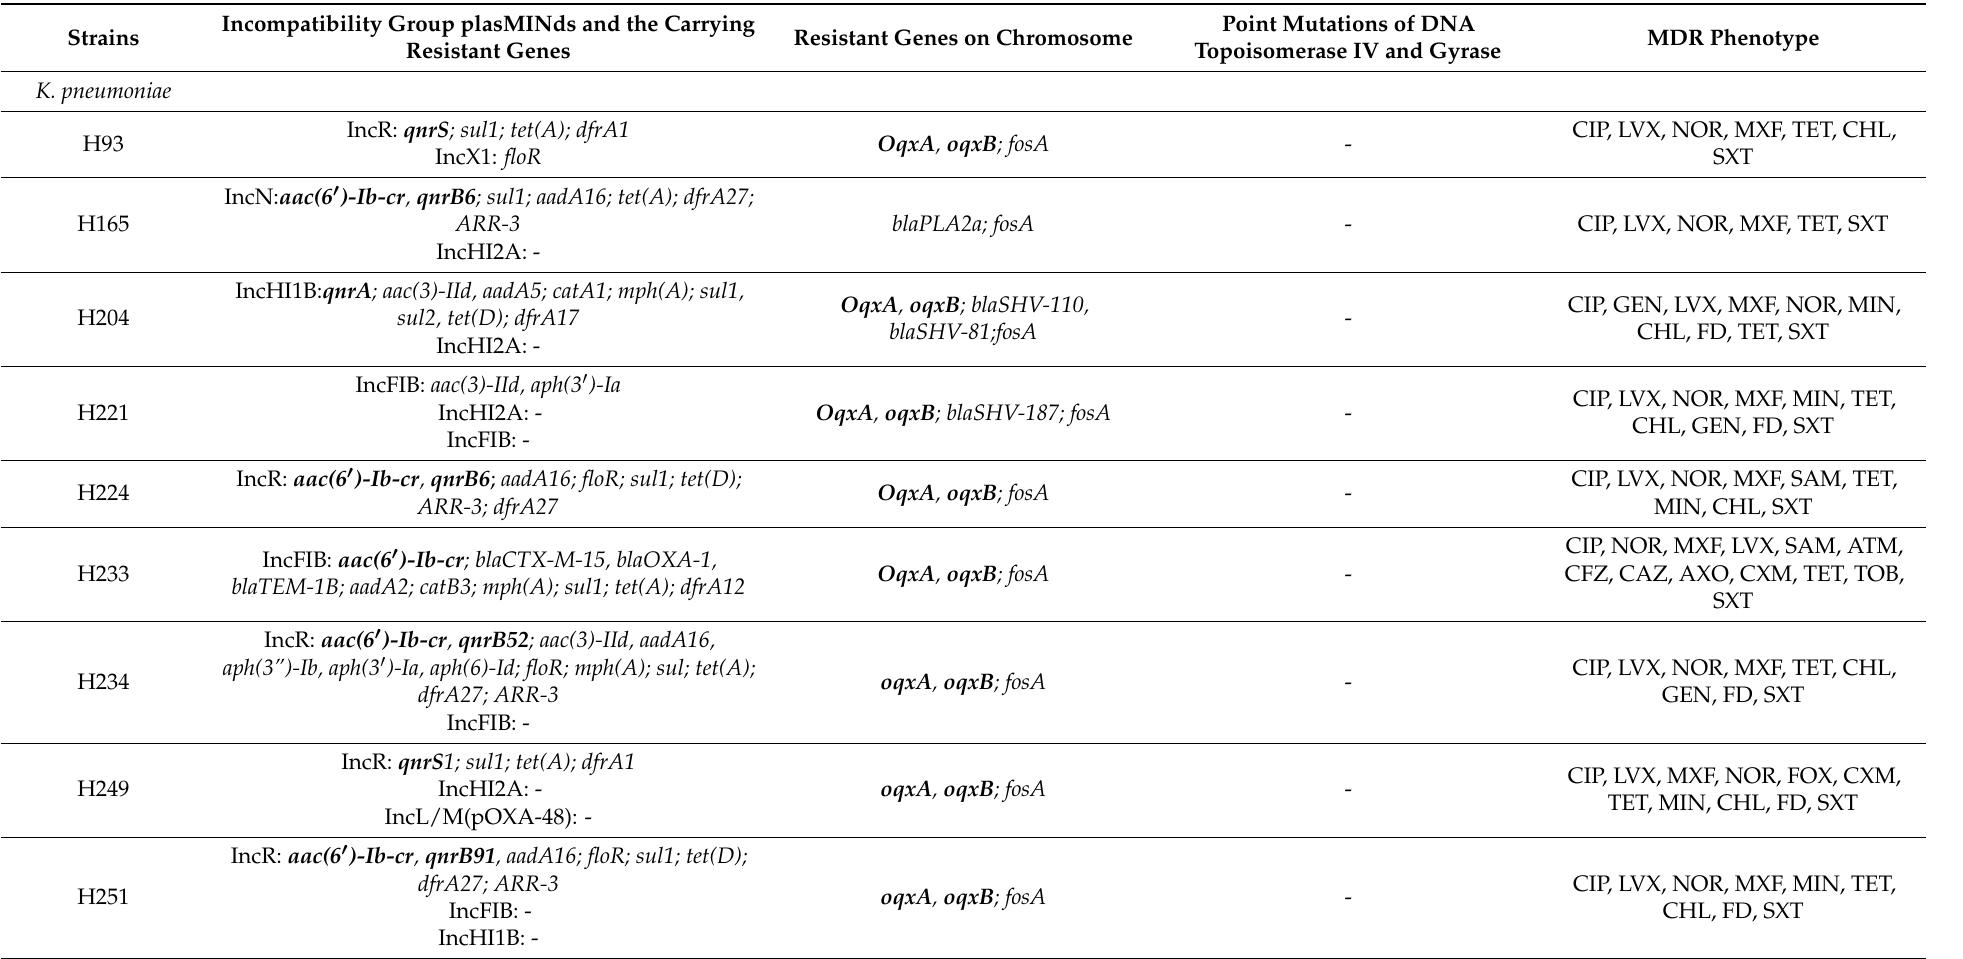
Point Mutations of